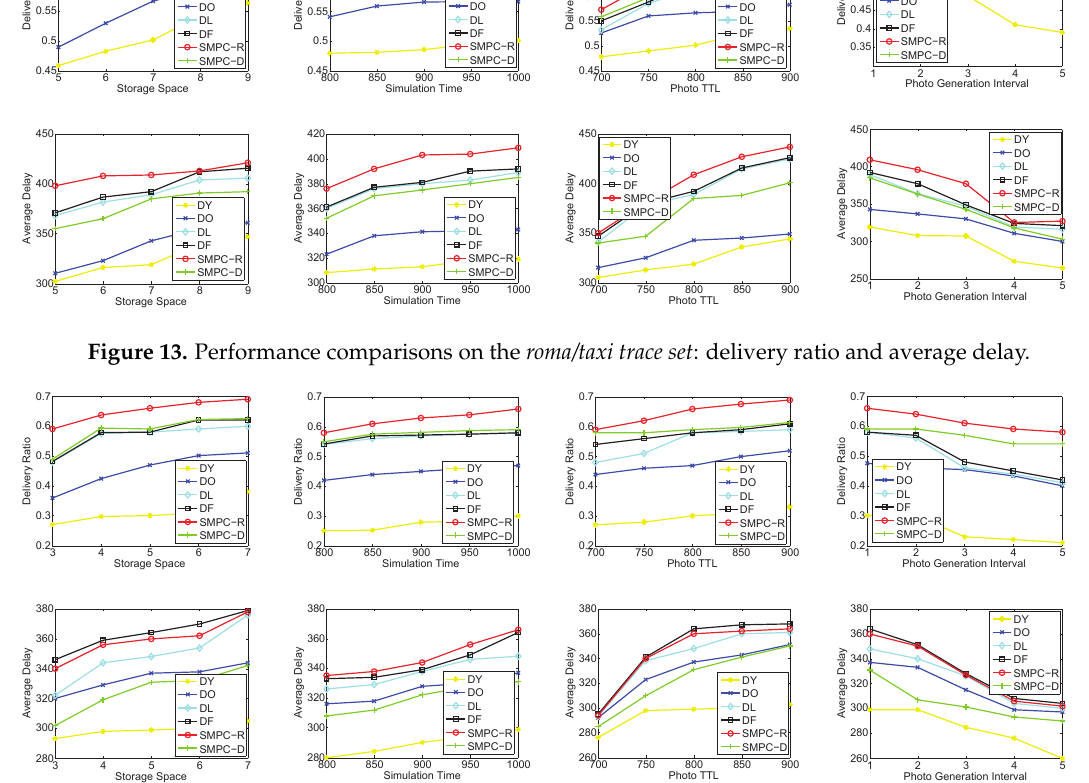
Figure 14. Performance comparisons on the epfl trace set : delivery ratio and average